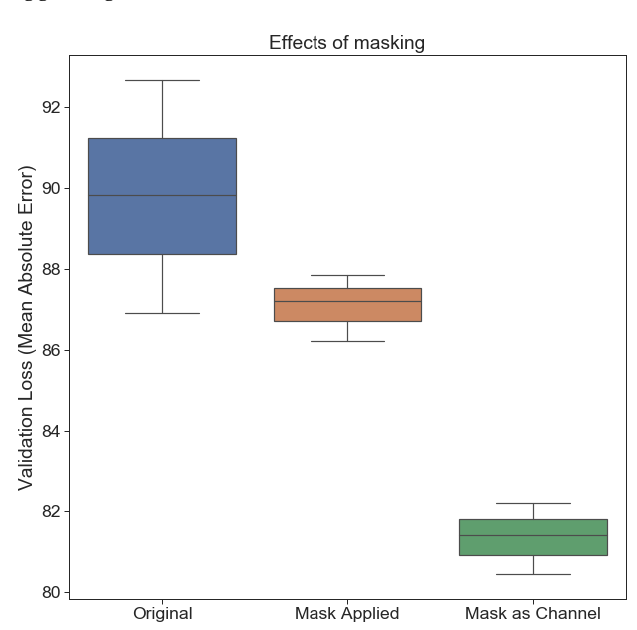
Figure 10. The effects of masking techniques on MAE.